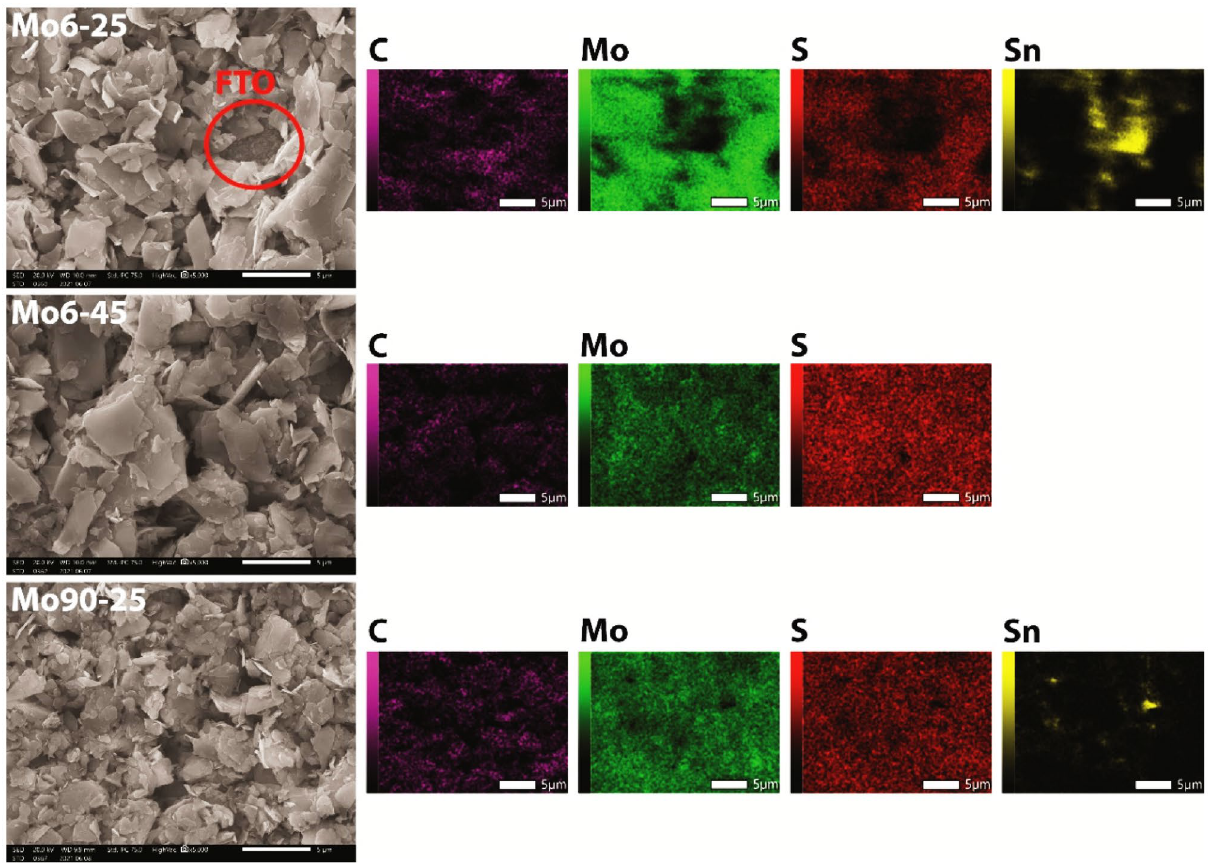
Figure 3. SEM/EDX analysis of printed Mo6-25, Mo6-45 and Mo90-25